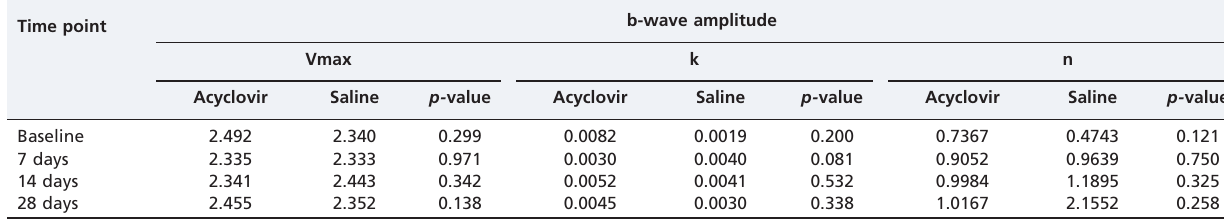
Table 2 - b-wave amplitude parameters obtained from the response versus log light intensity (VlogI) curve using the Naka-Rushton equation (dark-adapted state).